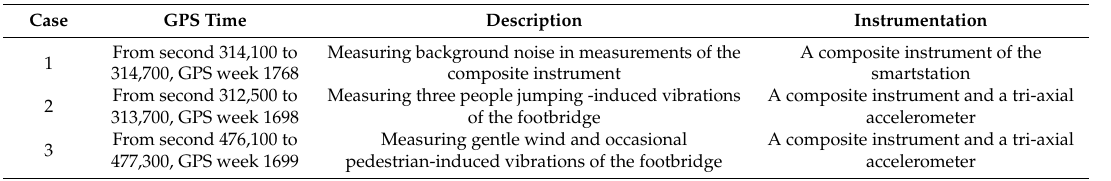
Table 1. The details of the three experimental